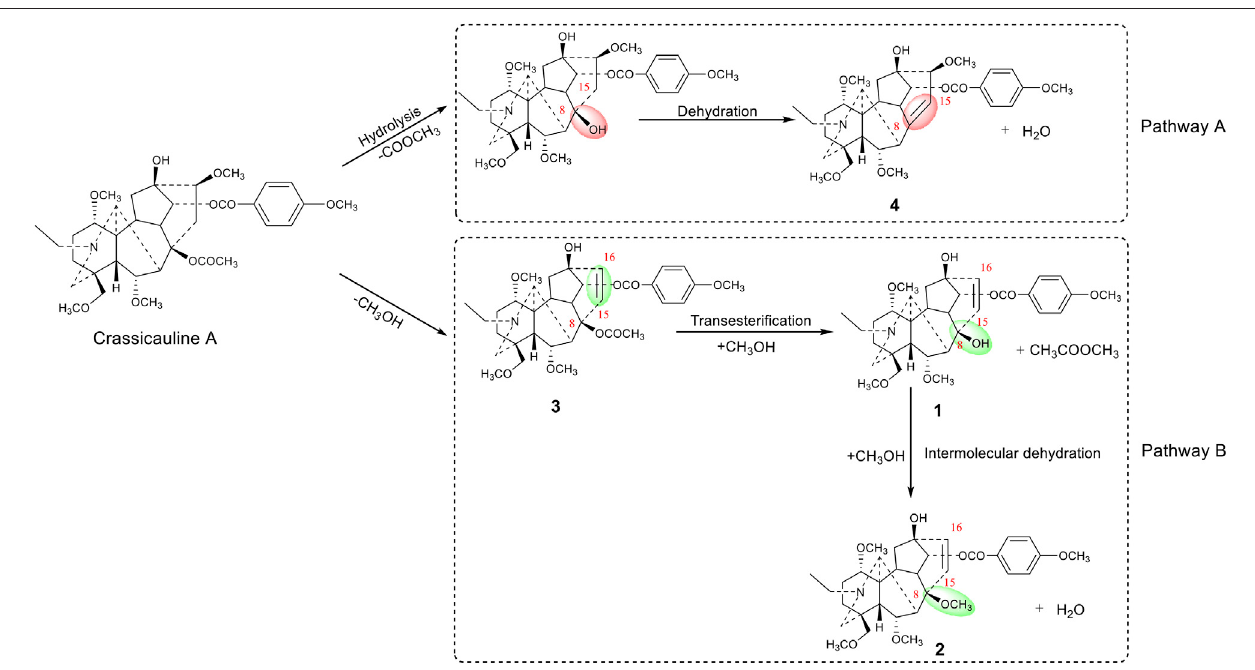
FIGURE 7 | Transformation pathways of crassicauline A during sand frying process.